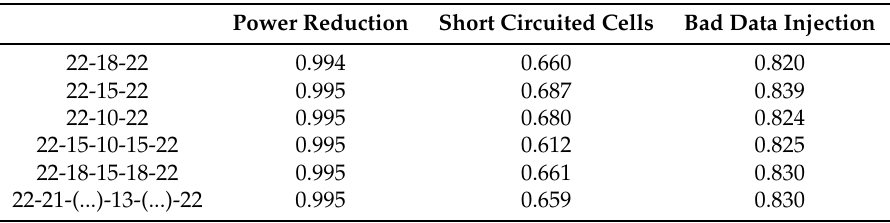
Table 3. Impact of the NN architecture on accuracy.